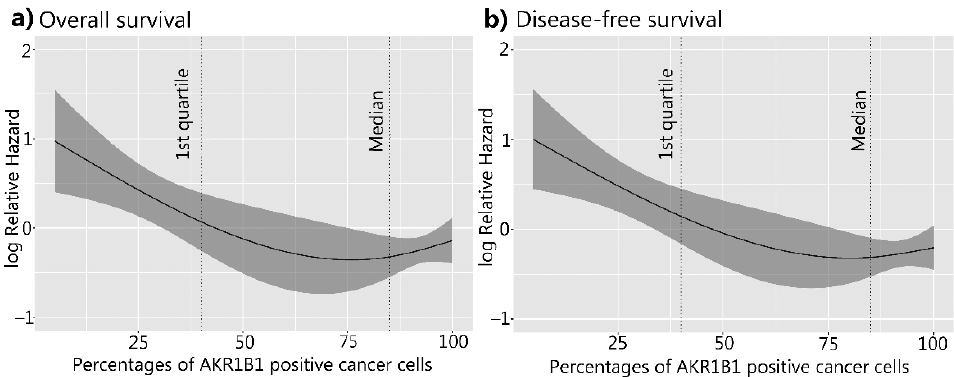
Figure 5. Representative hematoxylin and eosin staining of the same samples as shown in Figure 4.